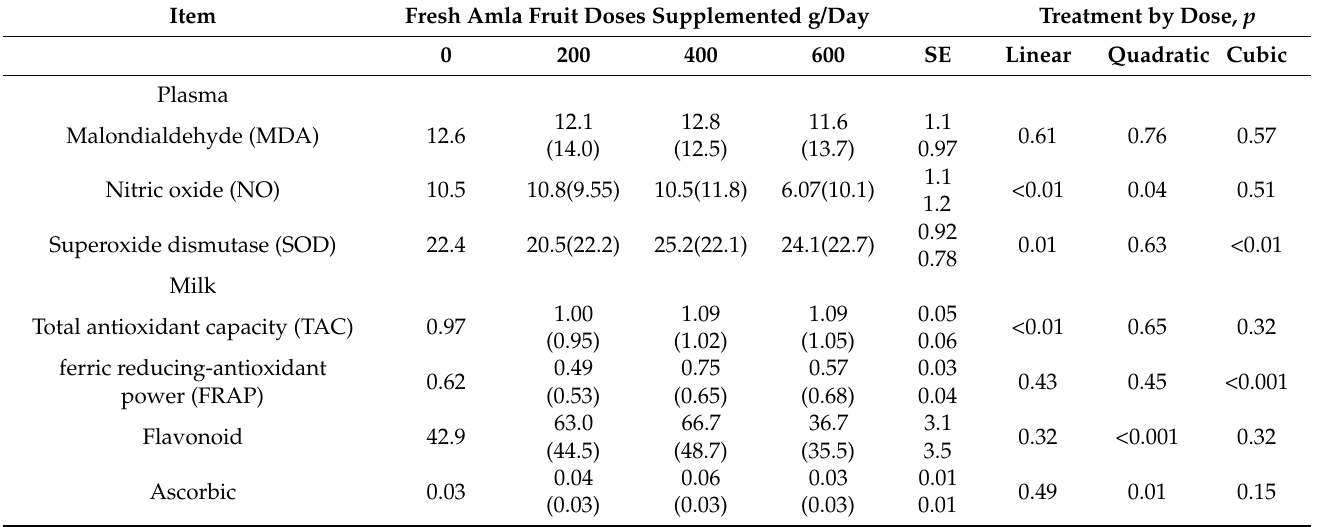
Table 7. Plasma and milk antioxidant capacity of lactating cows (n = 8) fed a TMR without